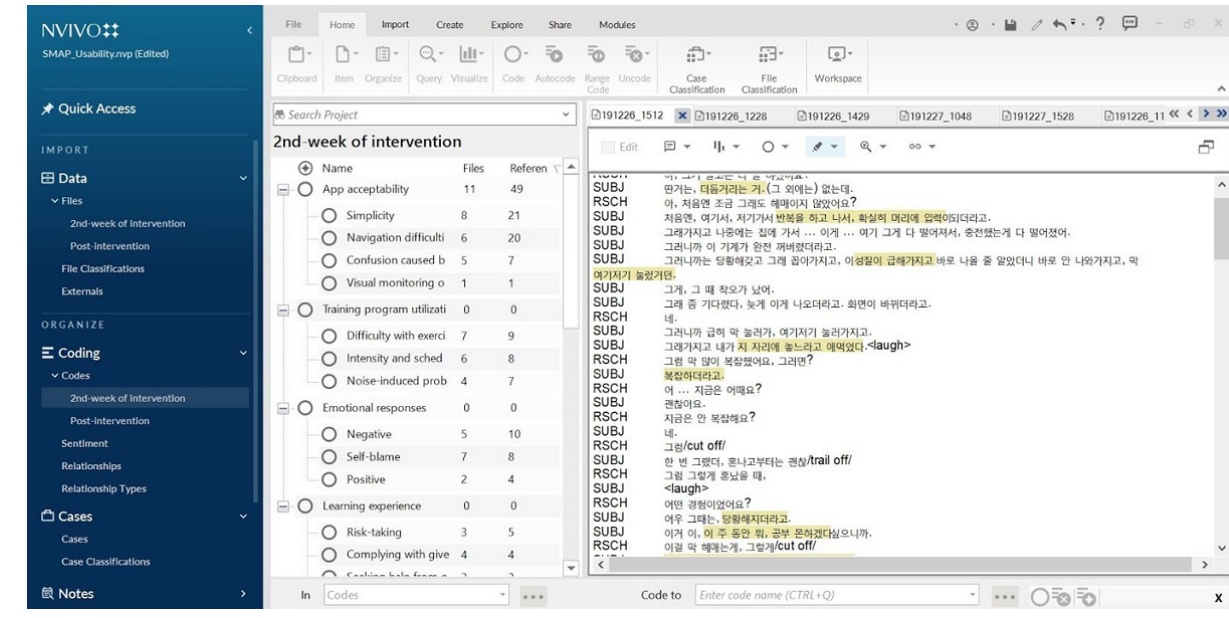
Figure 4. Example of the use of NVivo